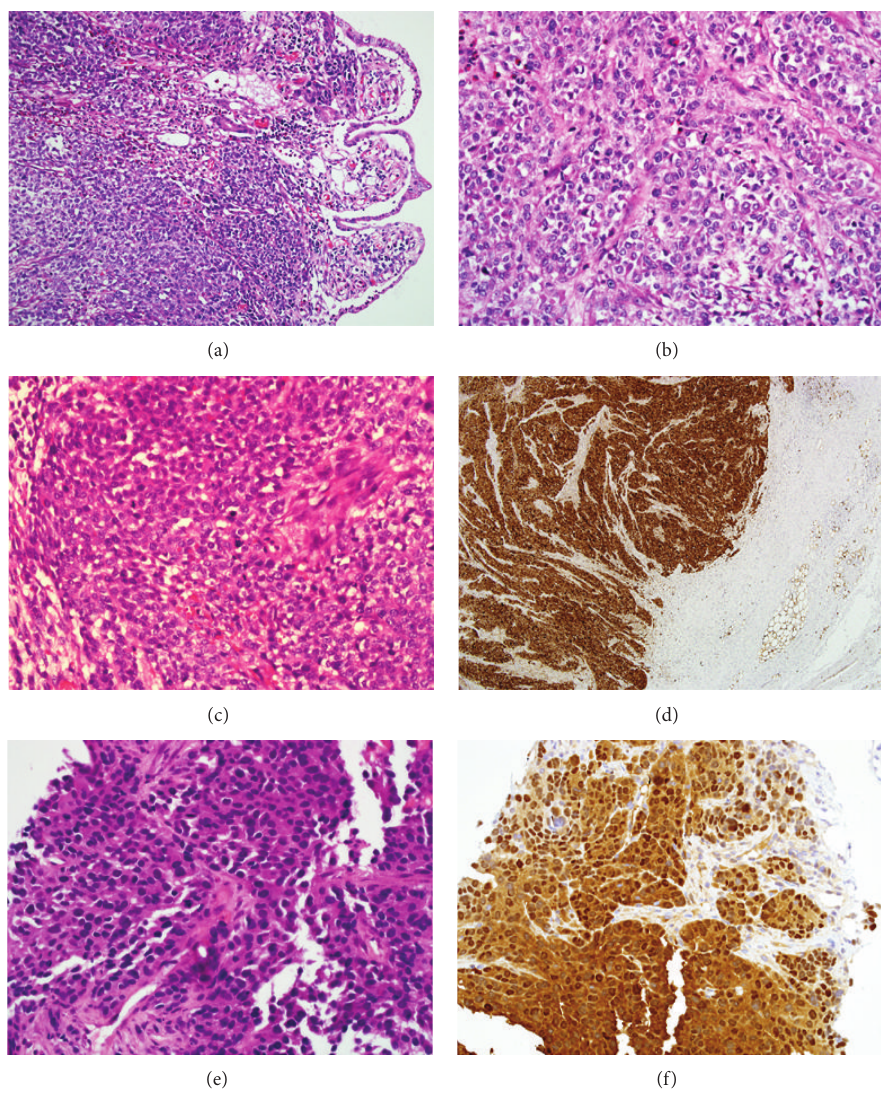
Figure 1: (a) Clear cell sarcoma-like tumor of the gastrointestinal tract (CCSLGT). Low power view shows diffuse infiltration of the wall of the small bowel completely destroying the muscularis propria and with obliteration of the intestinal mucosa leaving just a thin strip of epithelium overlying each of the villi. (b) The tumor comprises sheets and vague nests of epithelioid or ovoid cells which show moderate nuclear atypia and amphophilic or clear cytoplasm. The nests are much more ill defined than those seen in conventional soft tissue clear cell sarcoma of tendons and aponeuroses. (c) At higher power, the cells show medium sized ovoid to occasionally spindled vesicular nuclei and often small nucleoli. There are prominent mitotic figures. Here, the cells are present in a diffuse sheet-like pattern without discernible nested architecture. (d) There is diffuse nuclear and cytoplasmic expression of S100 protein. S100 protein expression without staining for melanocytic markers is typical of CCSLGT, although some cases may show patchier S100 protein immunoreactivity. Note the diffuse infiltration of the small bowel muscularis propria and tumor proximity to serosal fat. (e) Metastatic CCSLGT in the patient’s subsequent liver biopsy. The metastatic tumor has similar morphology, although it contains cells with amphophilic cytoplasm and no clear cytoplasm or any nested pattern. The lack of characteristic cytologic or immunophenotypic features and the lack of familiarity of pathologists with this neoplasm can understandably lead to confusion with other metastatic tumors with epithelioid or ovoid cell morphology. (f) Diffuse S100 protein expression is also present in the liver